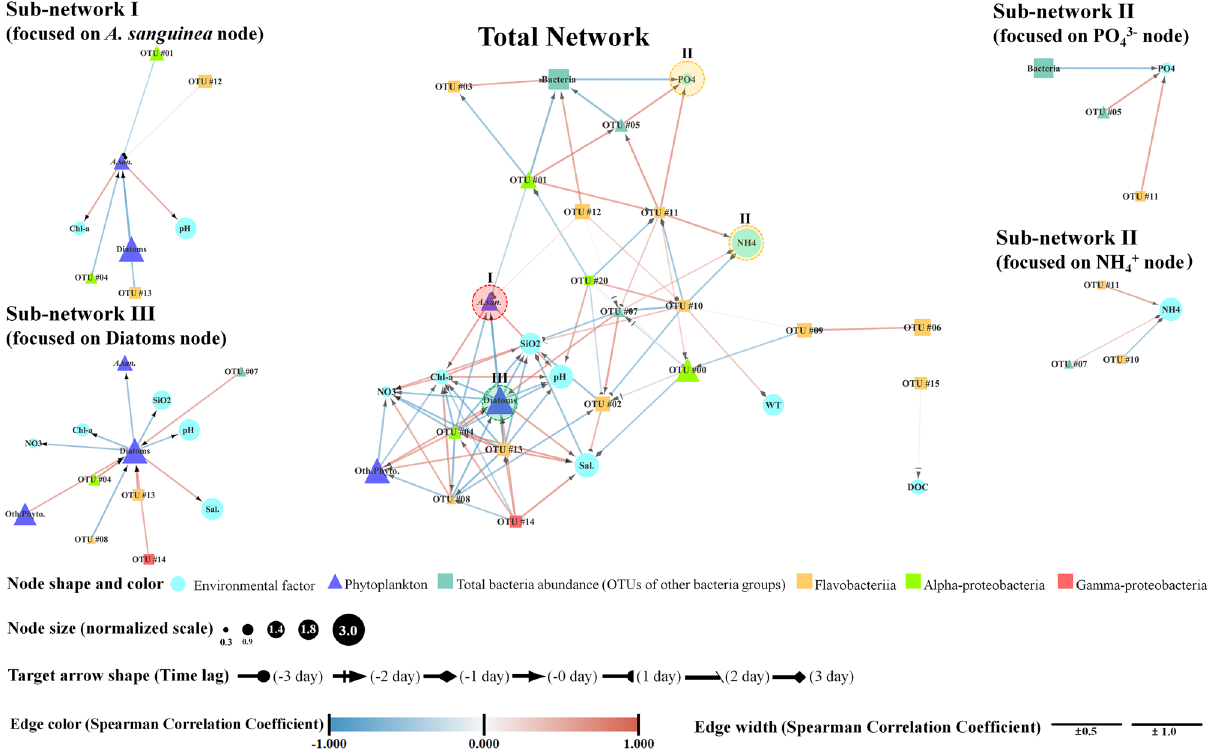
( P < 0.01; false discovery Q < 0.05). Zoomed images are the sub-networks (I-III) are associated with A. sanguinea ,